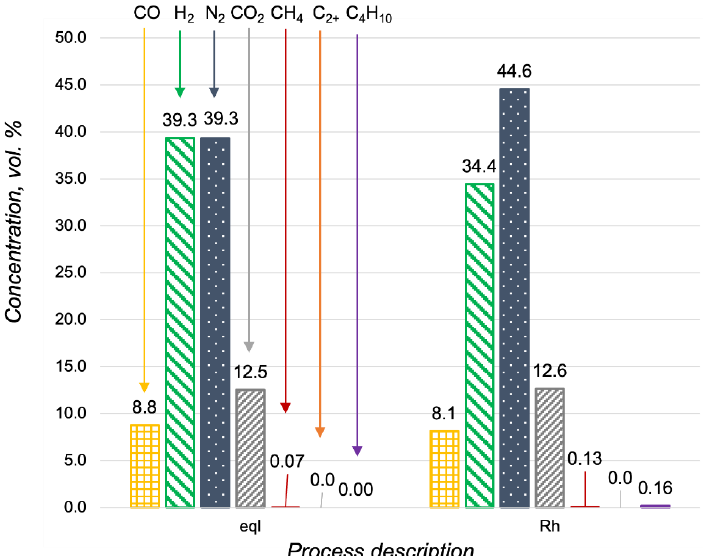
Figure 10. Product distribution in the n-butane oxidative steam reforming at 700 °C, with H 2 O/C = 2.5 O 2 /C = 0.5 in a thermodynamic equilibrium (eql) and over the Rh/CZA/FeCrAl at GHSV = 16,600 h −1 .